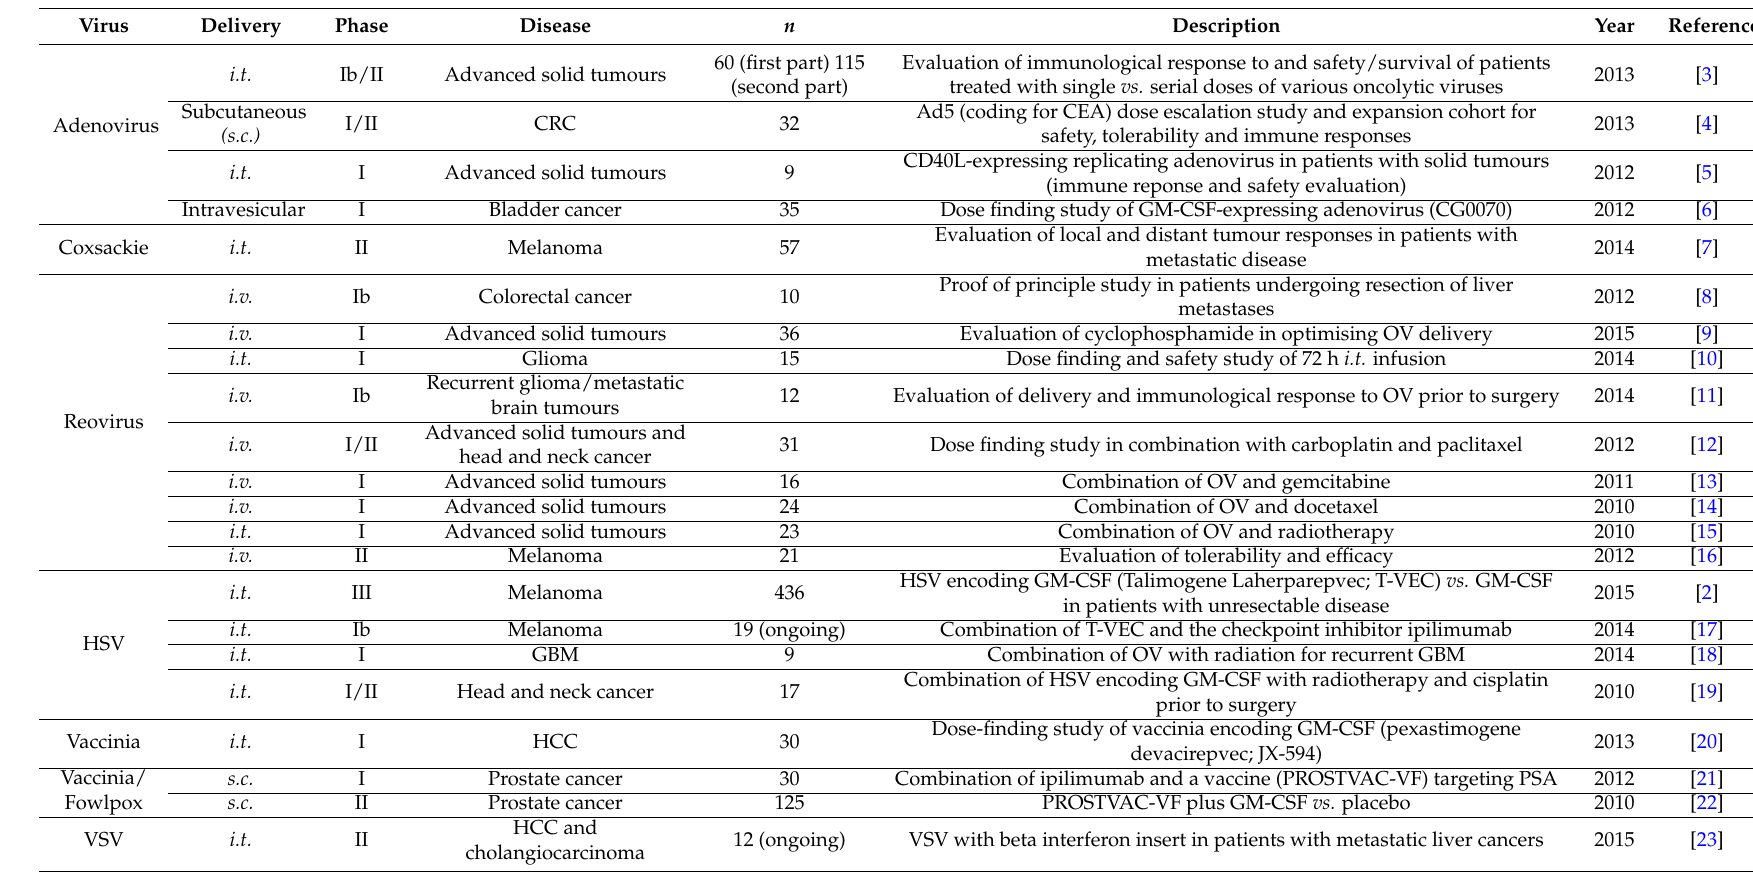
Table 1. A selection of recently published clinical trials of oncolytic